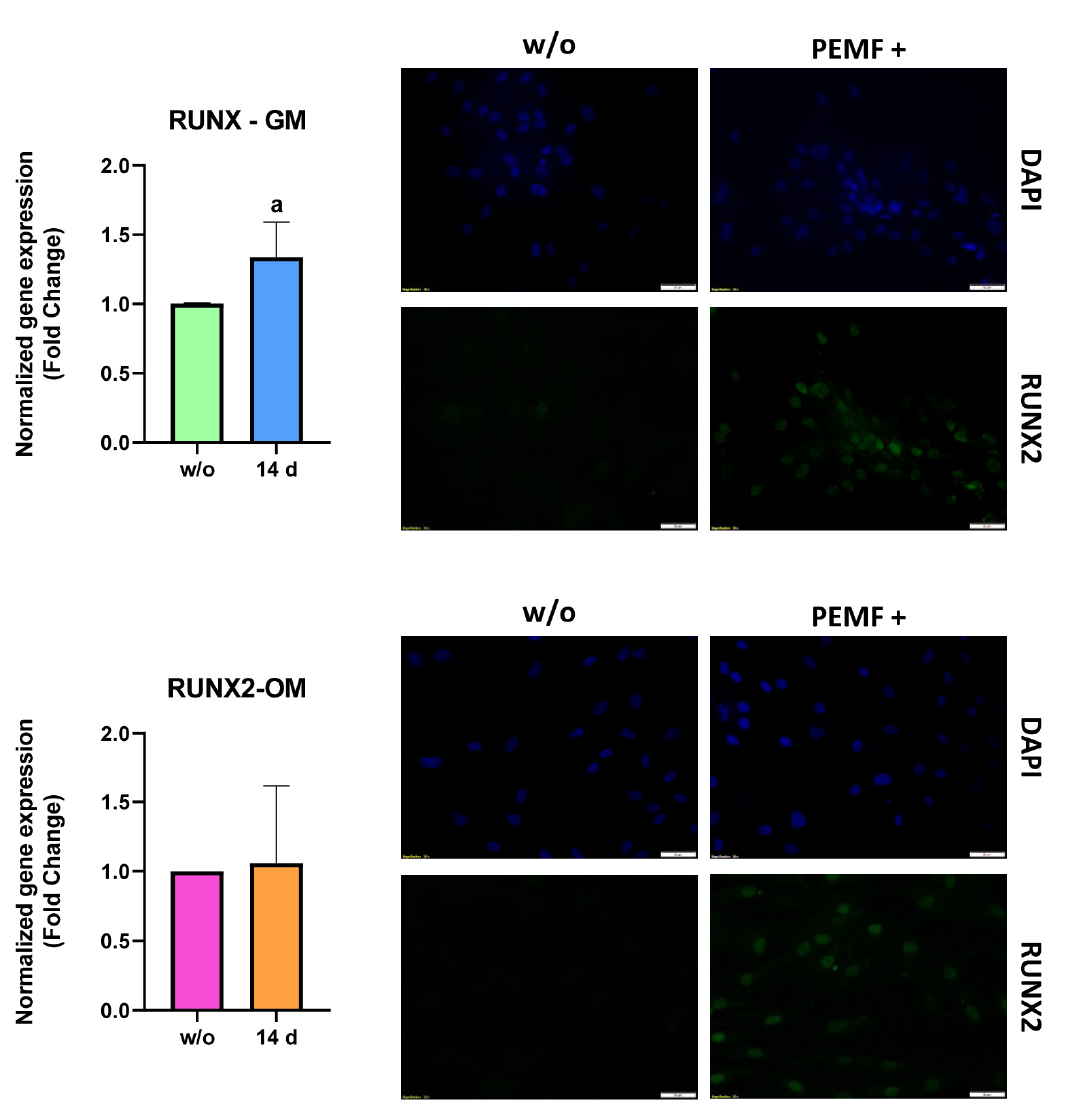
Figure 5. Immunofluorescence images of RUNX2 and gene expression at 14 days culture time. All the data reported are expressed as the mean ± S.E.M. of six independent experiments. Before the statistical analysis was performed, the raw data were tested for normality with Kolmogorov–Smirnov normality test and further analyzed with unpaired t -test on GraphPad Prism 8.4.2. The results were evaluated as statistically significant (a) when the p -value < 0.05. Scale bar: 50 µ m. COL1A1: In accordance with the qPCR results, the IF staining reported in Figure